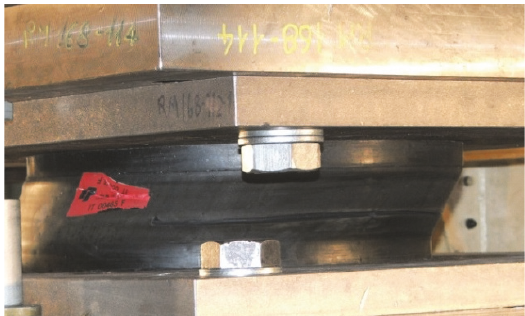
Figure 7: Damaged SI-H 500/50 prototype undergoing 350% shear strain test (courtesy of